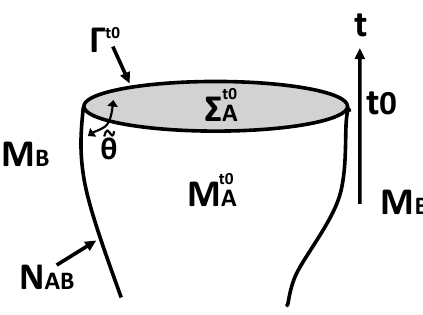
Figure 2 . A sketch of Lorentzian gravity setup for the canonical